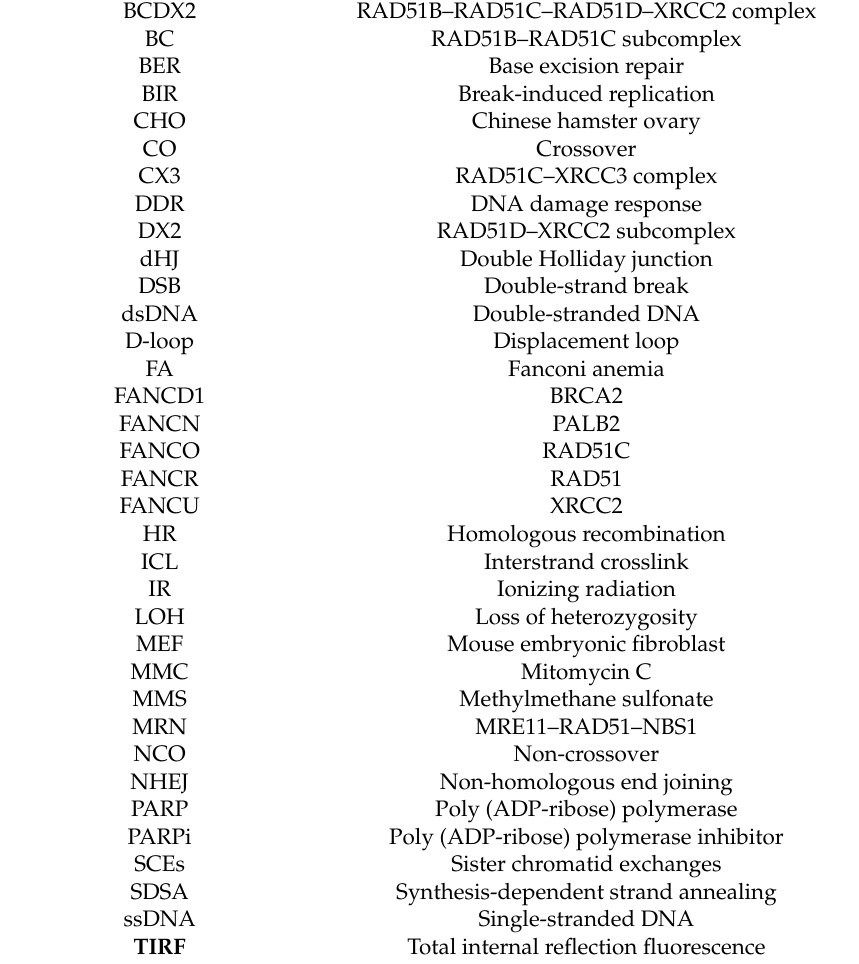
Table 1. Abbreviations